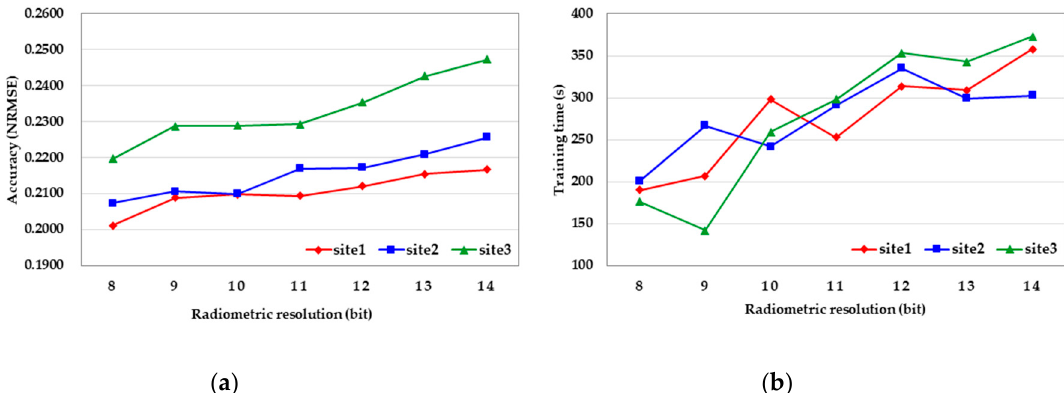
Figure 11. Experiments on the radiometric resolution: ( a ) accuracy by setting different radiometric resolutions, ( b ) training time by setting different radiometric resolutions.